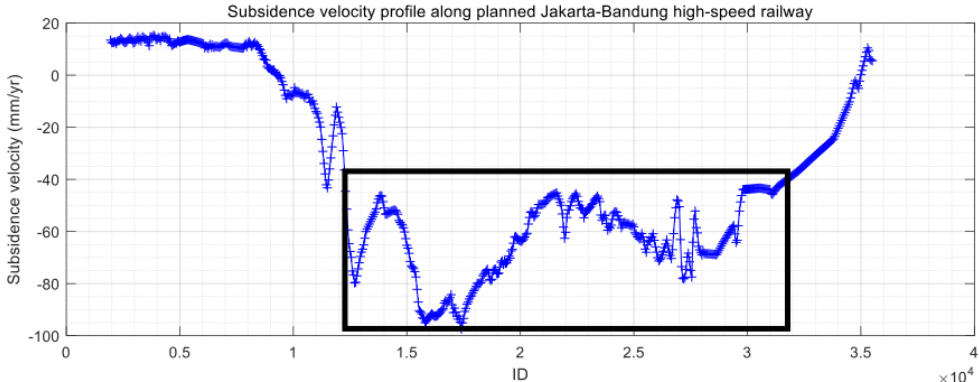
Figure 7. The subsidence velocity profile along the planned Jakarta-Bandung high-speed railway. There are two subsiding areas that are located in Margaarish Town that suffer from the serious subsidence that us highlighted with a black rectangle. The subsidence velocity ranges from −100 to −20 mm/yr.